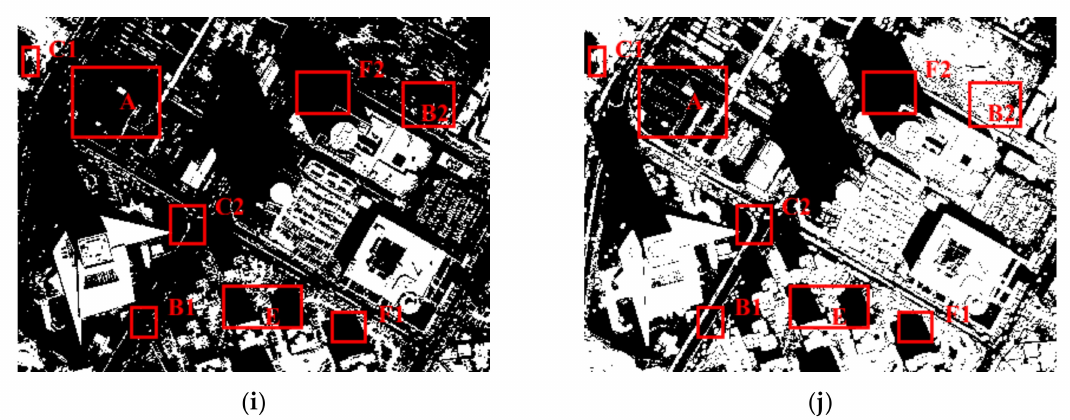
Figure 6. Shadow detection results of various shadow detection algorithms for Tripoli-1. ( a ) HIS. ( b ) HSV. ( c ) CIELCh. ( d ) YCbCr. ( e ) YIQ. ( f ) MC3 [18]. ( g ) Normalized saturation-value index